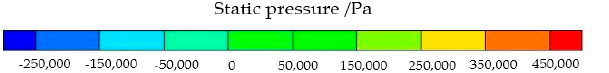
Figure 12. Variation of static pressure in different impellers.